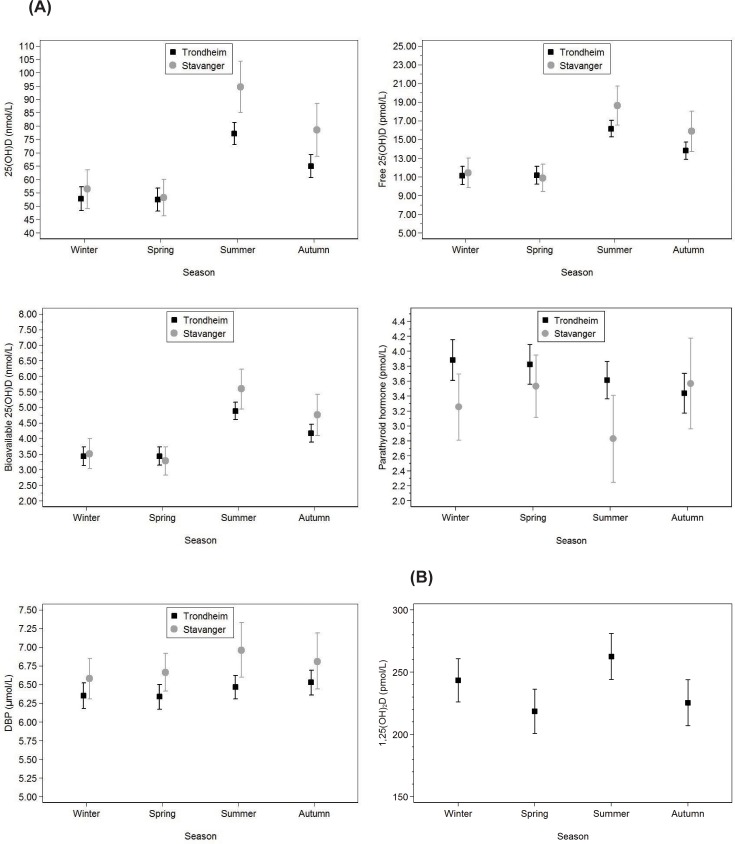
Seasonal variation of serum measures in third trimester.(A) Seasonal variation of serum total, free and bioavailable 25(OH)D, PTH and DBP in third trimester. (B) Seasonal variation of serum 1,25(OH)2D in third trimester, in a sub-analysis including 250 women living in Trondheim, Norway. Solid squares represent women living in Trondheim, Norway (latitude 63°N) and grey dots represent women living in Stavanger, Norway (latitude 58°N). Vertical lines represent 95% confidence intervals. A multivariable linear regression analysis was used, and separate analyses were performed for second and third trimester. In analyses involving 1,25(OH)2D, we used the pweight function in Stata to account for the sampling scheme (the inverse of the probability of an observation being selected into the sample). Abbreviations: PTH, parathyroid hormone, DBP, vitamin D-binding protein.